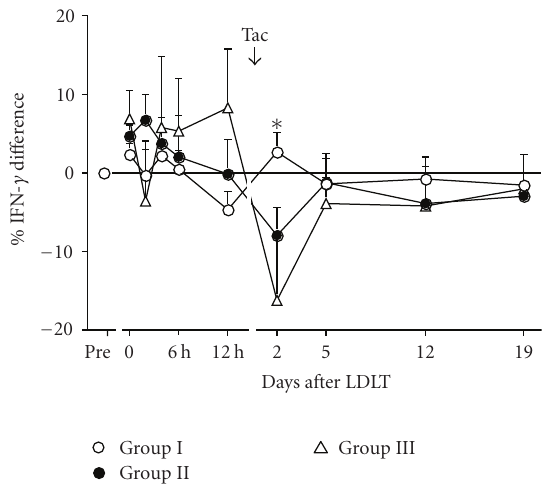
Figure 7: Changes in the % IFN- γ di ff erence after LDLT in 3 groups. ∗ P -value at day 2 is based on analysis of variance: all, .0161. P -values between 3 groups are based on Student’s t -test: Group I versus II, .0248; Group I versus III, .0133; and Group II versus III,